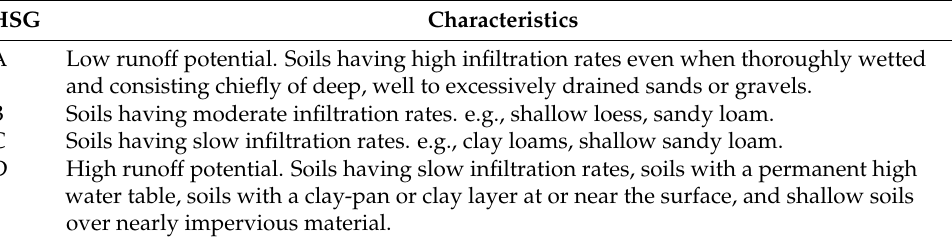
Table 5. Hydrological Soil Group (HSG) characteristics [87,89].